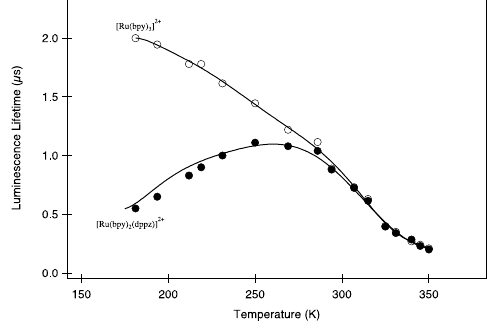
Figure 4. Schematic representation of the luminescence lifetime with temperature for ] 2+ and [Ru(bpy) (DPPZ)] 2+ [Ru(bpy) 3 2